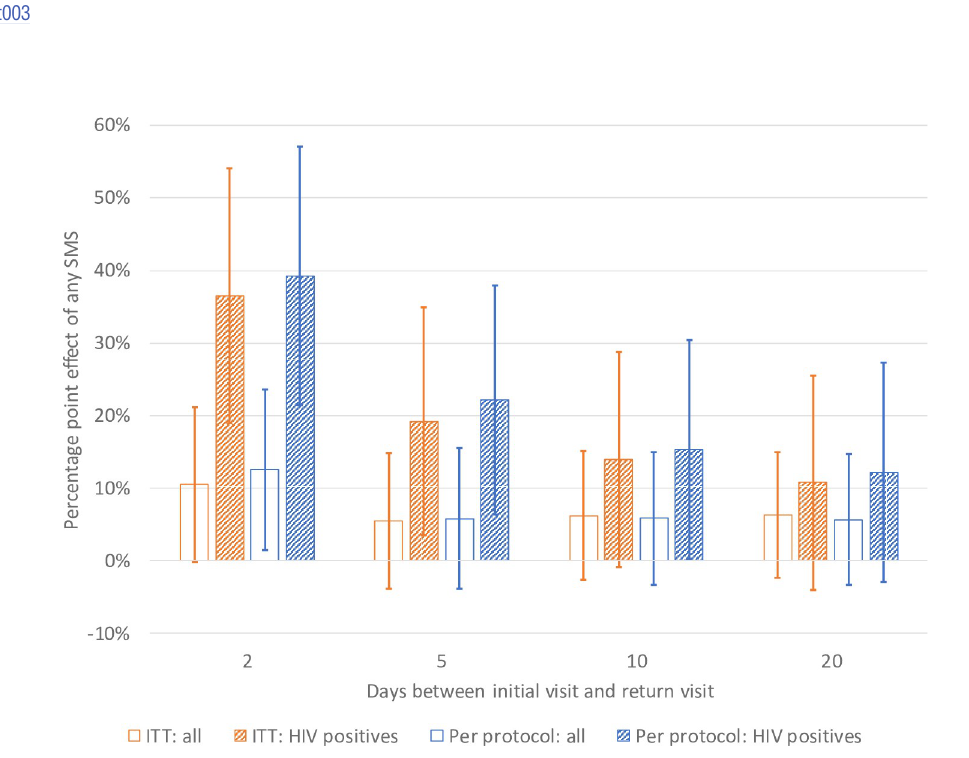
Fig 2. ITT and per-protocol results: Percentage point effect from any SMS. Lines represent 95% confidence intervals.